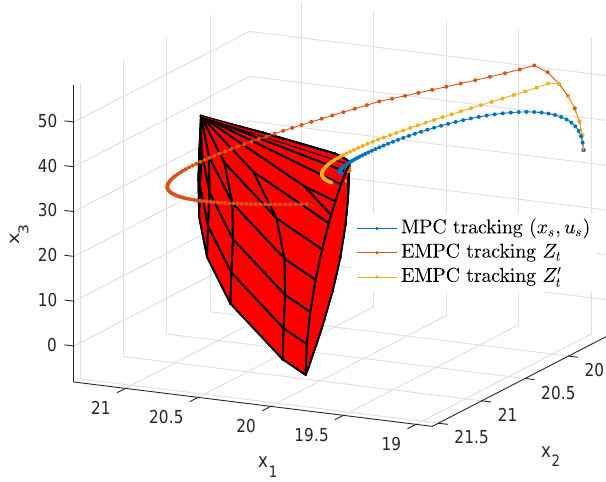
Figure 8. Phase space plot of different control schemes. The polyhedron depicts the modified target zone Z (cid:48) t .